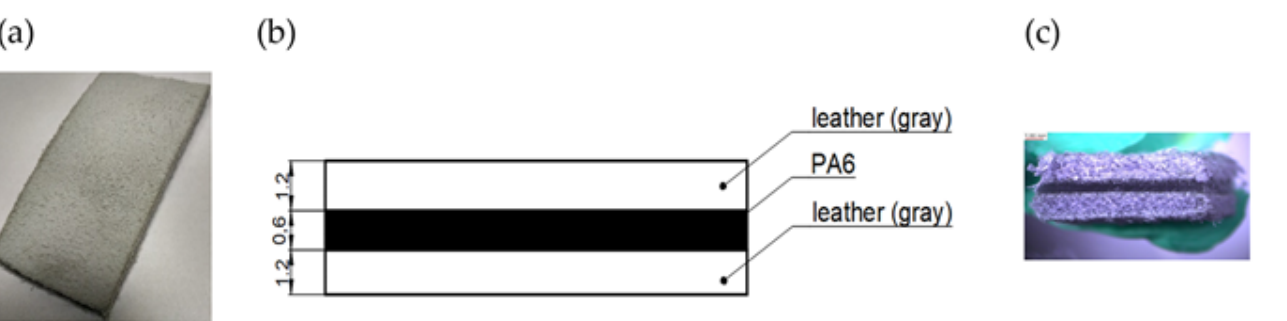
Figure 1. NE22 flat lane ( a ) photography, ( b ) belt cross section, ( c ) optical light microscopy images of the internal structure.